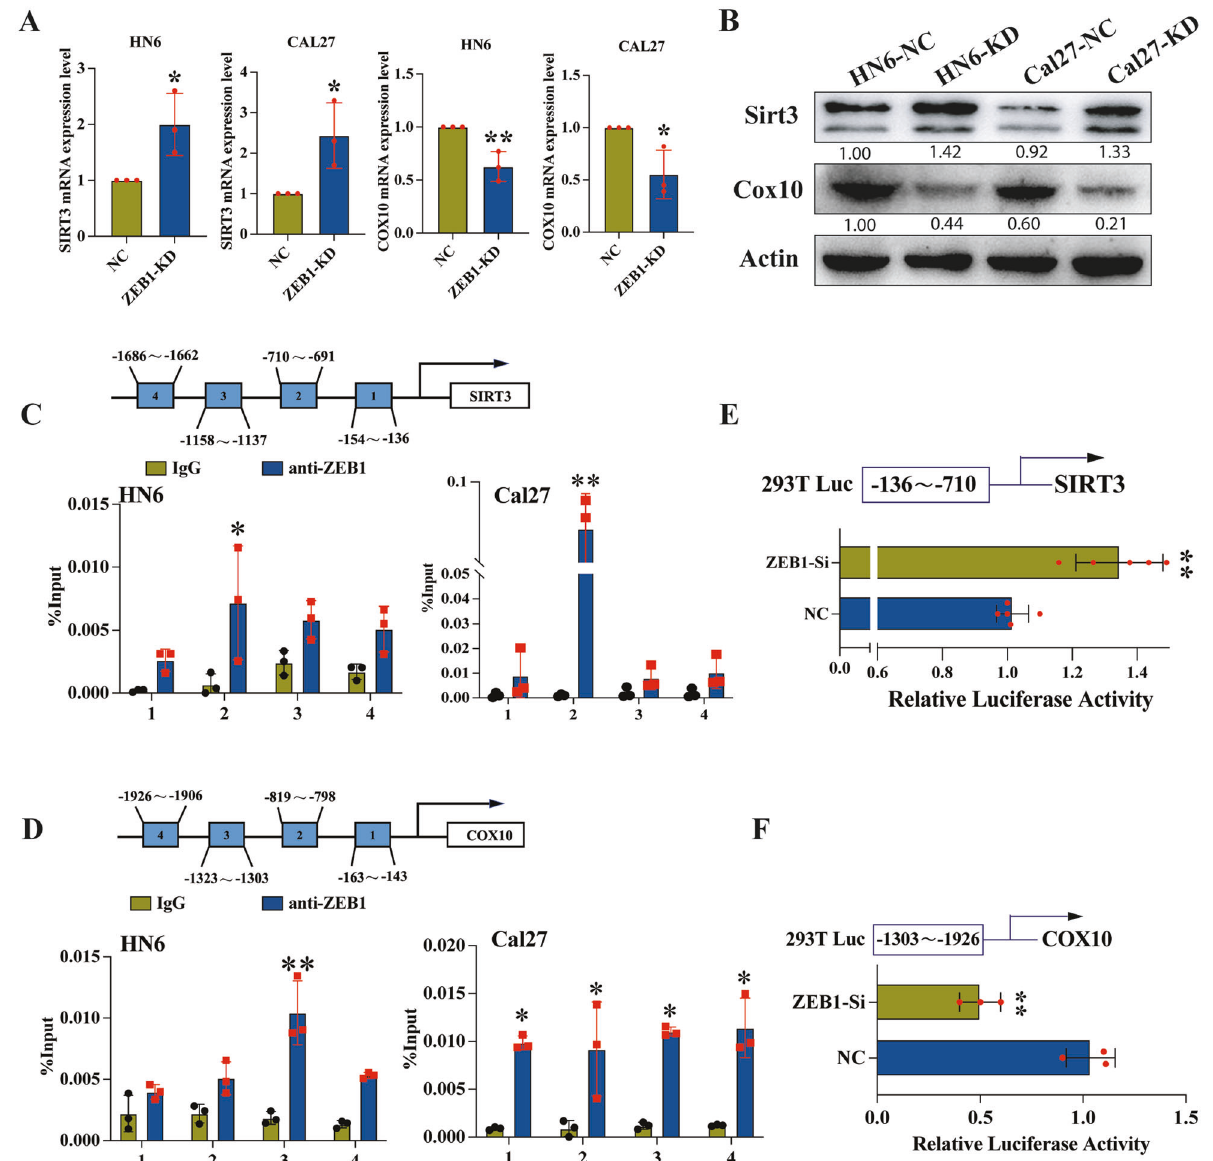
Fig. 6 SIRT3 and COX10 are transcription targets of ZEB1. A Representative qPCR analysis of SIRT3 and COX10 expression in ZEB1-depletion cell lines. B Immunoblotting for SIRT3 and COX10 in ZEB1-knockdown cells. C , D Four primers were designed to cover the human SIRT3 or COX10 promoter regions and were used to identify ZEB1 binding sites in ChIP assays. E Luciferase reporter assay indicated that the luciferase activity was signi fi cantly increased in ZEB1-depletion cells containing the reporters with binding site of SIRT3. F The luciferase activity was signi fi cantly decreased in ZEB1-depletion cells containing the reporters with binding site of COX10. (Median values are plotted in the column with data generated from at least three independent biological replicates, statistical analysis was performed by unpaired t -tests. KD knockdown, NC negative control, Si small interferon. The data was presented as mean ± SD, * P < 0.05, ** P <